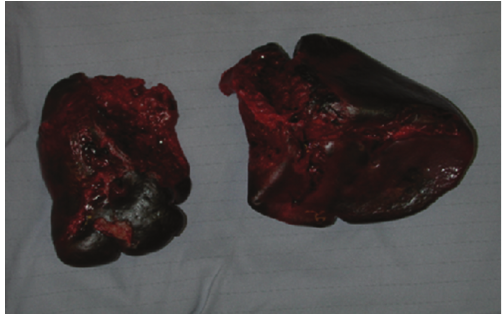
Figure 3: Case I: Appeared intact on CT but avulsed and in 2 pieces at